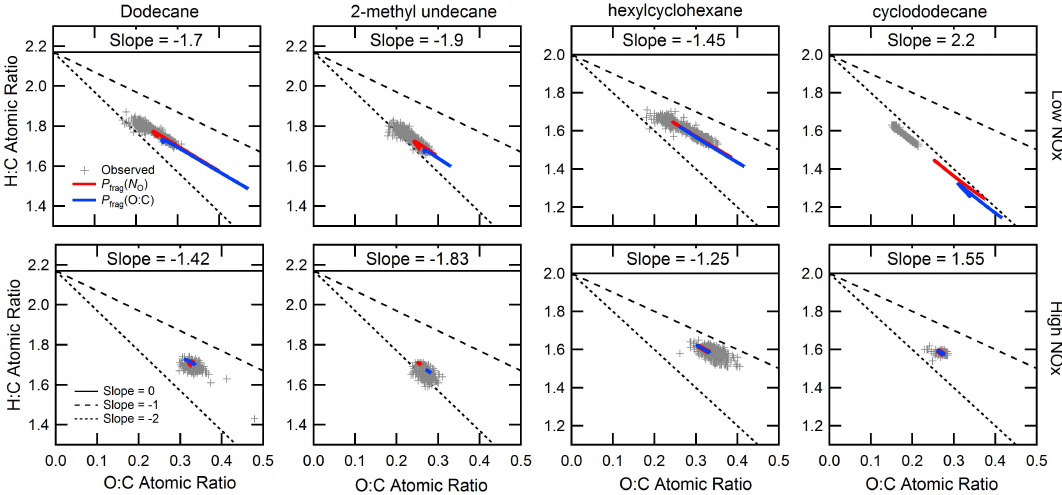
Fig. 3. Van Krevelen diagrams (H:C vs. O:C) for the observed SOA (gray points) and the model SOA using the P frag (N O ) (red lines) and P frag (O:C) (blue lines) fragmentation parameterizations. The top row shows results for low-NO x conditions and the bottom row for high-NO x conditions. The Van Krevelen slopes (defined according to the parent hydrocarbon y-intercept) are given in each